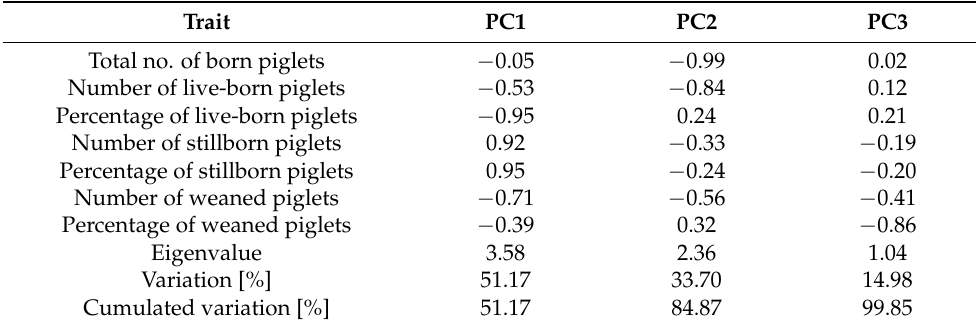
of variation. Table 11. PCA for marker S0064 in Polish Landrace sows: Eigenvalues, variance explained, cumula- tive variance explained, and correlation coefficients with the original traits of the first three principal components (PCs). Trait PC1 PC2